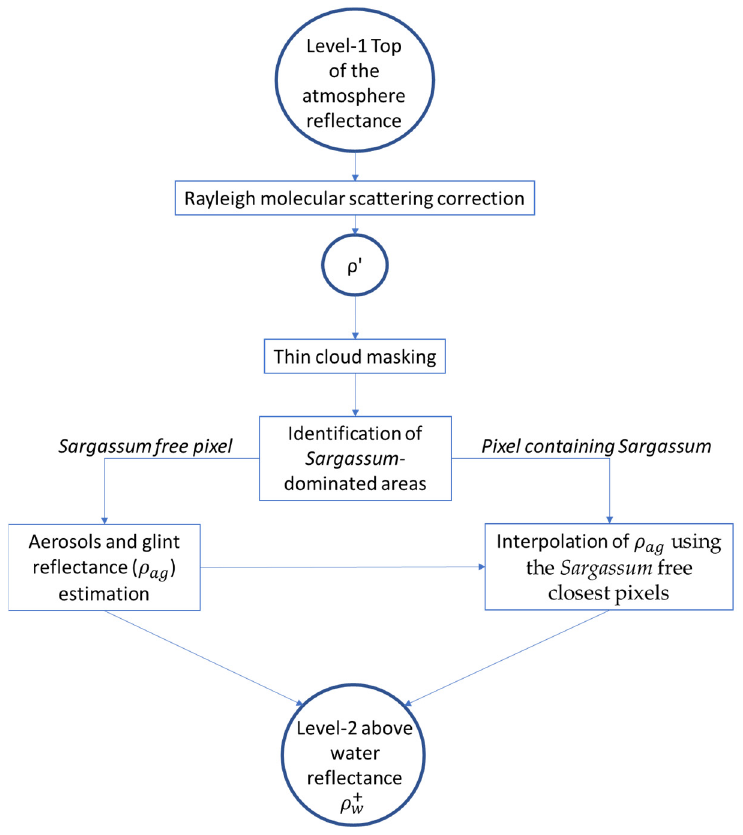
Figure 5. Flowchart of the POLYMER ext procedure to correct the top-of-atmosphere reflectance over Sargassum -dominated areas.